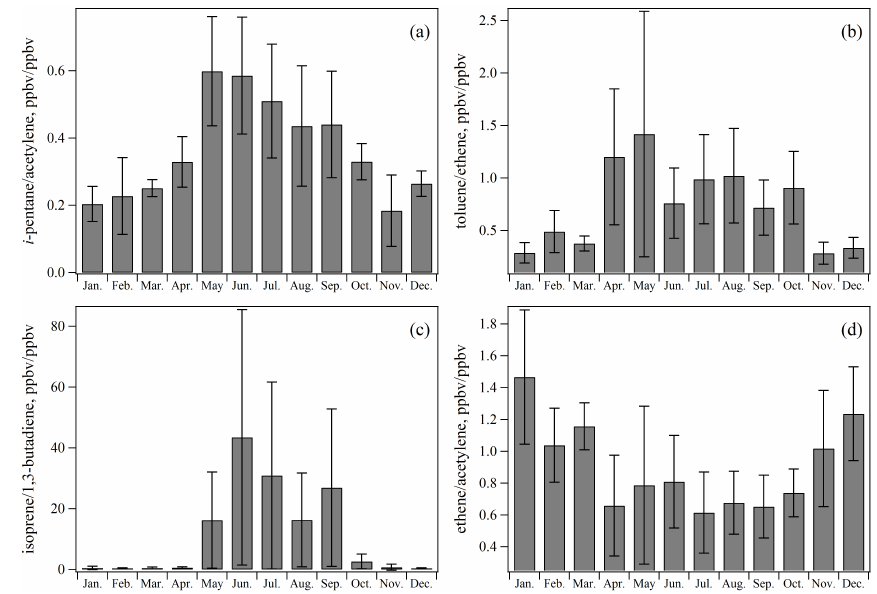
Figure 2. Monthly variations in the average ratios of (a) i -pentane to acetylene, (b) toluene to ethene, (c) isoprene to 1,3-butadiene, and (d) ethene to acetylene at urban sites in Beijing. Error bars represent one standard deviation from the mean ratios calculated at the 27 measuring sites.